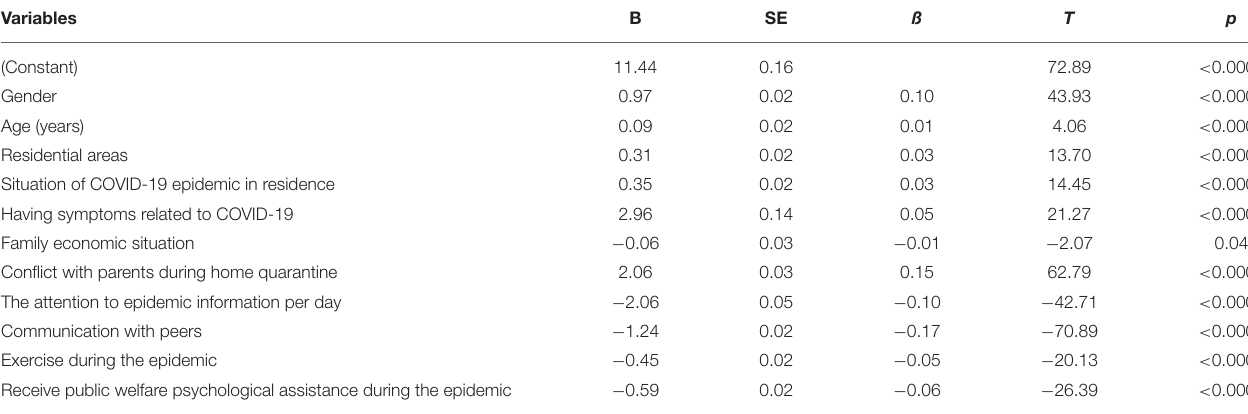
TABLE 3 | Results of multiple linear regression analysis of influencing factors for depressive symptoms.